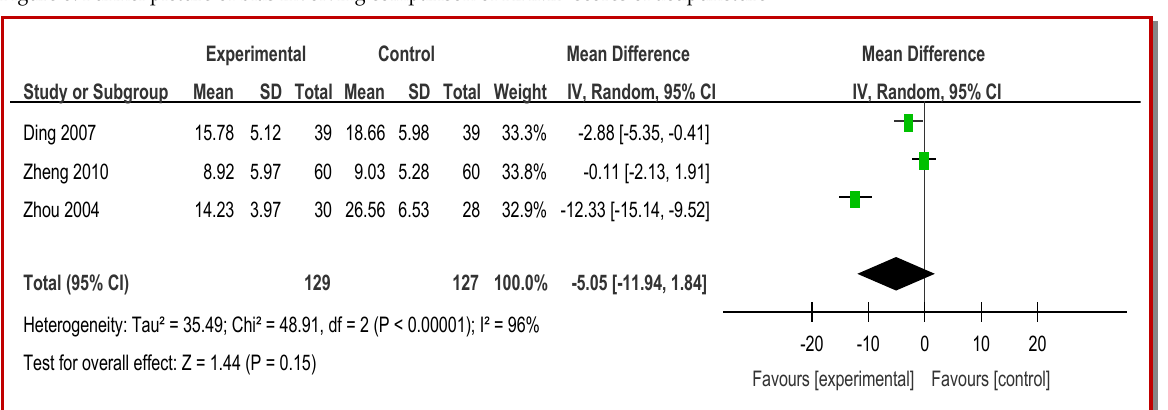
Figure 8: Funnel picture of bias involving comparison of HAMD scores of acupuncture